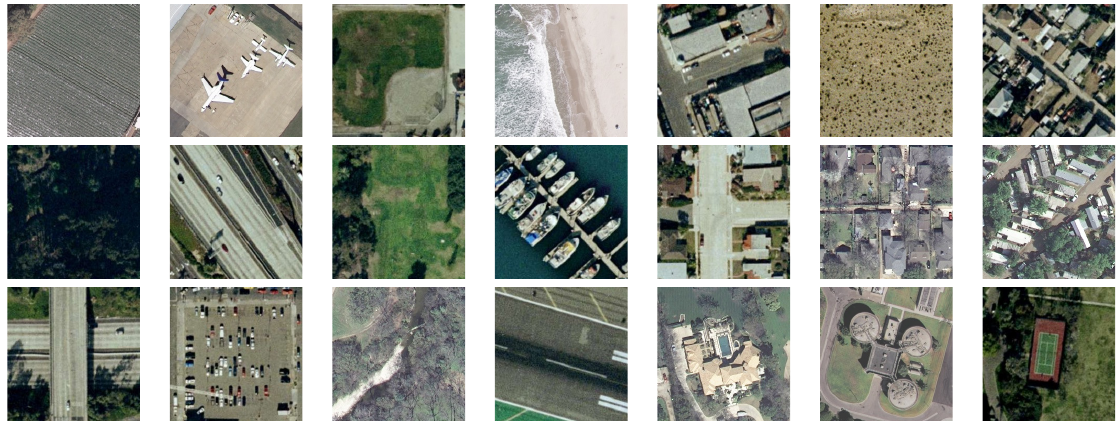
Figure 3. Illustration of the 21 classes from the Merced dataset.